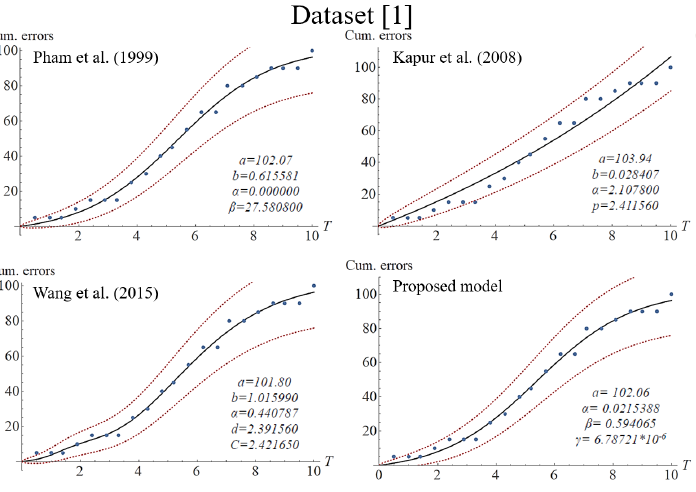
Figure 2. Goodness-of-Fit, Estimated Values of Models’ Parameters, and 95% Confidence Intervals for Dataset (1).